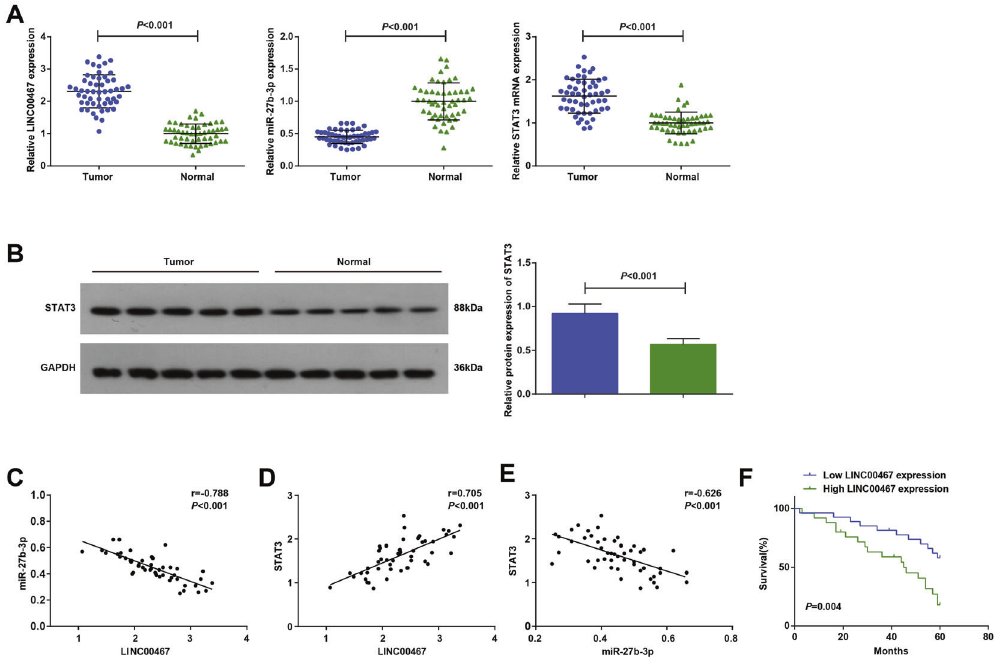
Fig. 1 LINC00467 and STAT3 are elevated while miR-27b-3p is depleted in GC tissues. ( A ) expression of LINC00467, miR-27b-3p, and STAT3 in GC tissues and adjacent normal tissues. ( B ) Protein band and protein expression of STAT3 in GC tissues and adjacent normal tissues. ( C ) Relation between levels of LINC00467 and miR-27b-3p in GC patients was analyzed by Pearson test. ( D ) Relation between levels of LINC00467 and STAT3 in GC patients was analyzed by Pearson test. ( E ) Relation between levels of miR-27b-3p and STAT3 in GC patients was analyzed by Pearson test. ( F ) Survival prognosis of GC patients was analyzed by Kaplan – Meier; n = 52; * P < 0.05 vs the adjacent normal tissues; the measurement data were expressed as mean ± standard